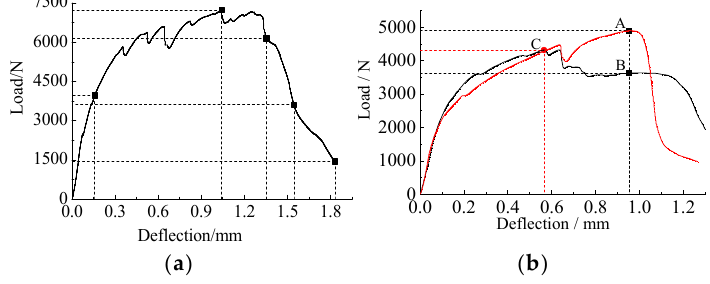
Figure 10. Typical load-deflection curves of HDC: ( a ) HC56-2-29; ( b ) HC56-1.5-29.